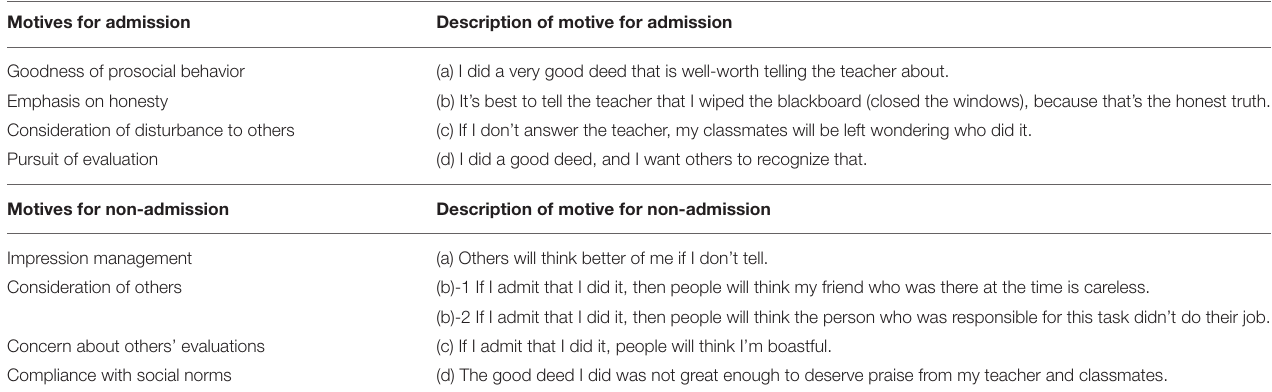
TABLE 1 | Content of items regarding possible motives for admitting or not admitting to performing the prosocial